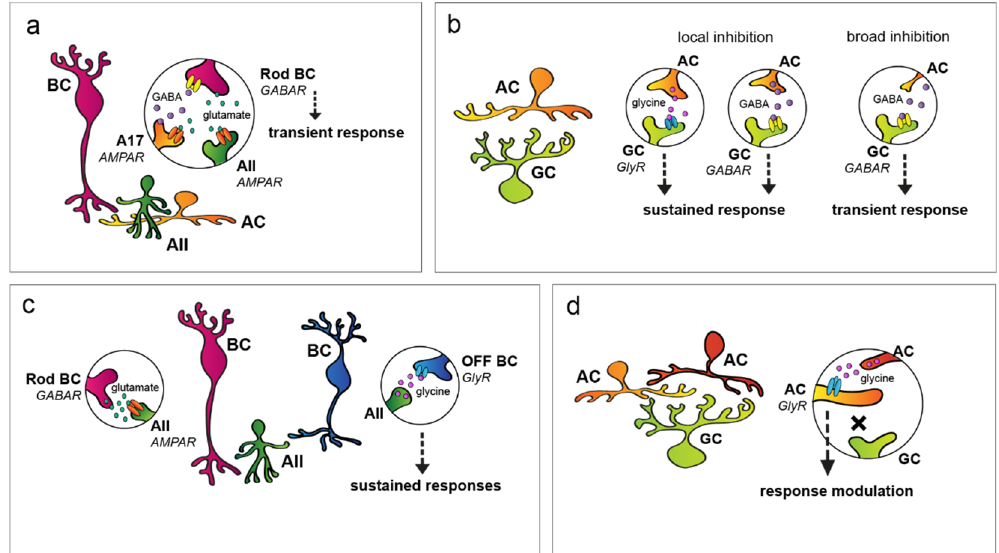
Figure 7. Inhibitory mechanisms in the inner retina. ( a ) Upon glutamate release from rod bipolar cells (BCs, magenta), A17 amacrine cells (ACs, orange) provide a relative sluggish GABAergic inhibitory feedback to rod BCs and make BC and postsynaptic AII AC (green) responses more transient. ( b ) ACs also provide feedforward inhibition to retinal ganglion cells (RGCs) in the inner retina. Both glycinergic and GABAergic interactions result in more sustained RGC responses in certain circuits (two middle panels), whereas the activation of some GABAergic contacts results in more transient RGC responses (rightmost panel). ( c ) Certain ACs in the retina, upon activation, provide opposite polarity inhibition to inner retinal neurons. In the presented circuit, AII ACs (green) receive glutamatergic excitation from rod BCs (magenta) that have ON polarity, and in turn, the AII cell forms inhibitory glycinergic synapses with opposite polarity OFF cone BCs (blue). This type of interaction is called crossover inhibition. ( d ) ACs (red) often make inhibitory synapses with other ACs (orange). Via such disinhibitory mechanisms, the transience of the final output RGCs (green) can be finely tuned to suit certain visual functions.